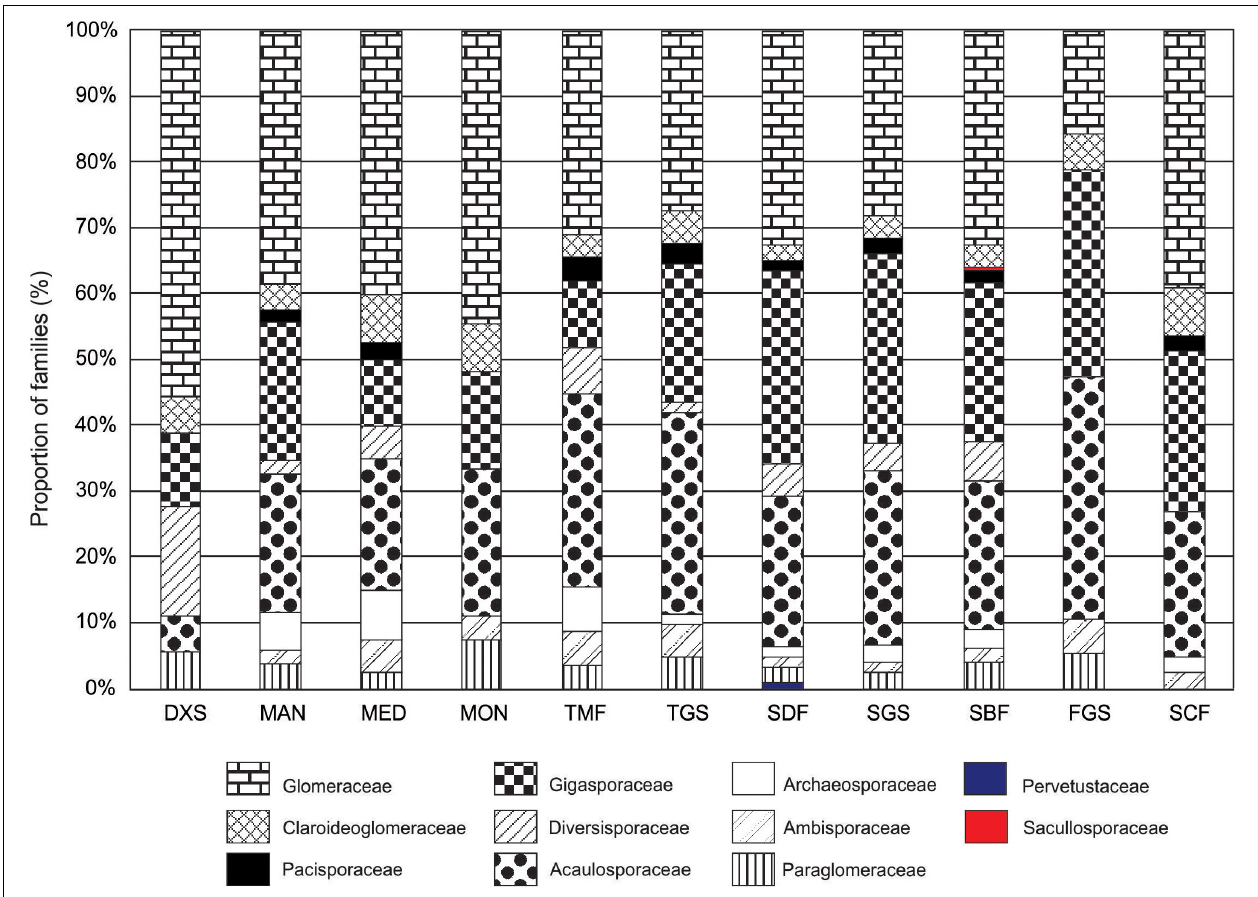
FIGURE 2 | Proportion of families (%) in Glomeromycota based on the number of species per family in Neotropical biomes. DXS, Desert and Xeric Shrublands; MAN, Mangroves; MED, Mediterranean Forests, Woodlands & Scrub; MON, Montane Grasslands & Shrublands; TMF, Temperate Broadleaf & Mixed Forests; TGS, Temperate Grasslands; Savannas & Shrublands; SDF, Tropical & Subtropical Dry Broadleaf Forests; SGS, Tropical and Subtropical Grasslands; Savannas & Shrublands; SBF, Tropical & Subtropical Moist Broadleaf Forests. FGS, Flooded Grasslands & Savannas; SCF, Tropical and Subtropical Coniferous